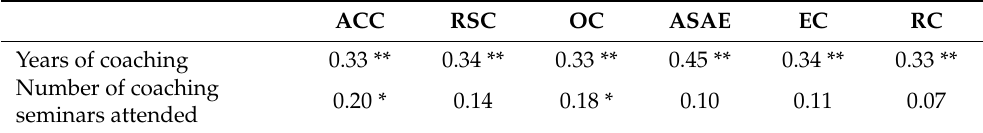
Table 6. Relationship between the years of coaching and DC competencies’ possession. ACC RSC EC Years of